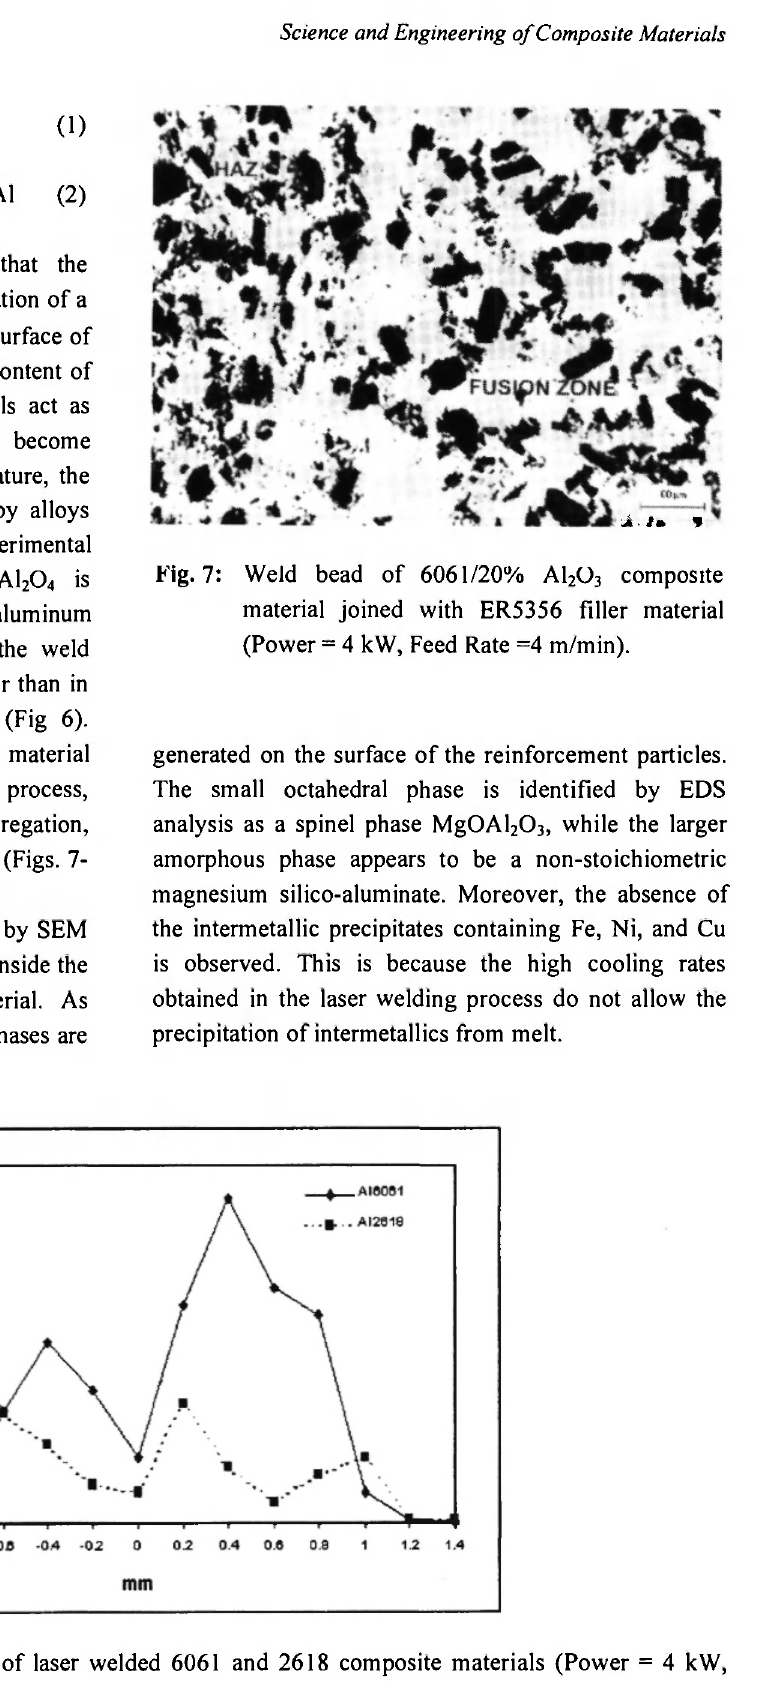
Fig. 6: Differences in microhardness profiles of laser welded 6061 and 2618 composite materials (Power = 4 kW, Feed Rate = 4